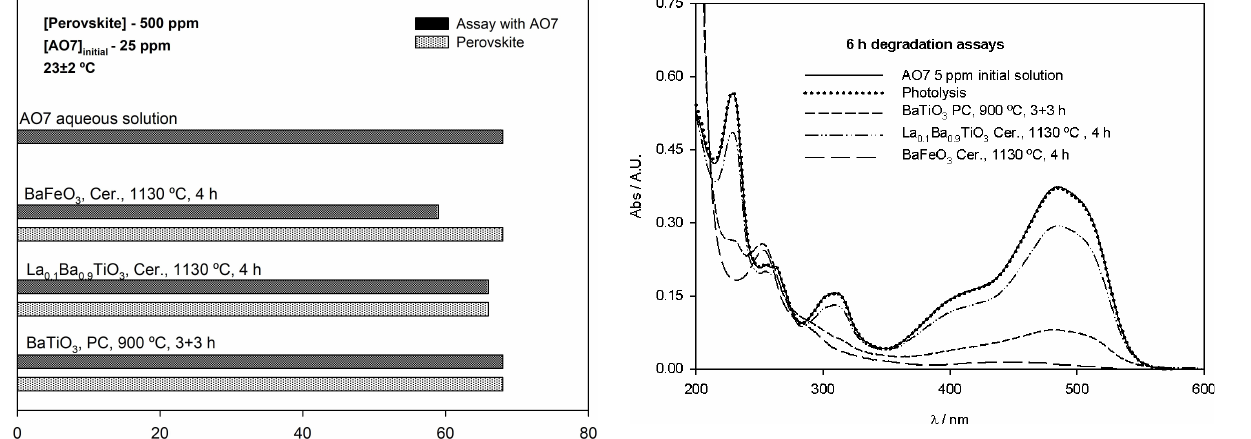
Figure 5: UV-Vis. Absorption spectra of the final solutions of the photocatalytic 6h-degradation assays performed with AO7 5 ppm aqueous solutions utilizing 500 ppm suspensions of different